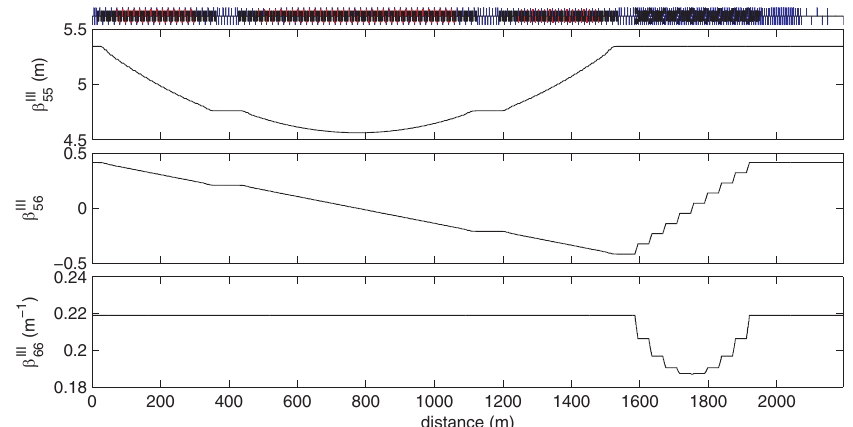
FIG. 2. (Color) Longitudinal lattice functions in part of a 16 km ILC damping ring lattice.